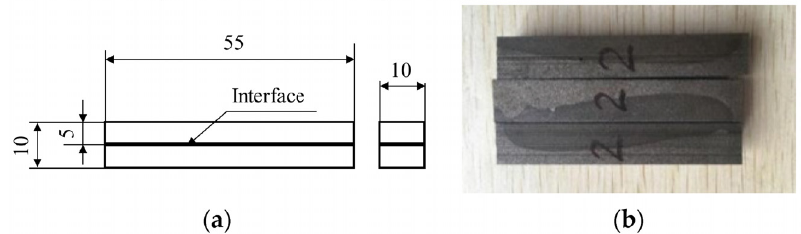
Figure 4. Samples for impact tests: ( a ) schematic drawing and ( b ) physical photo.